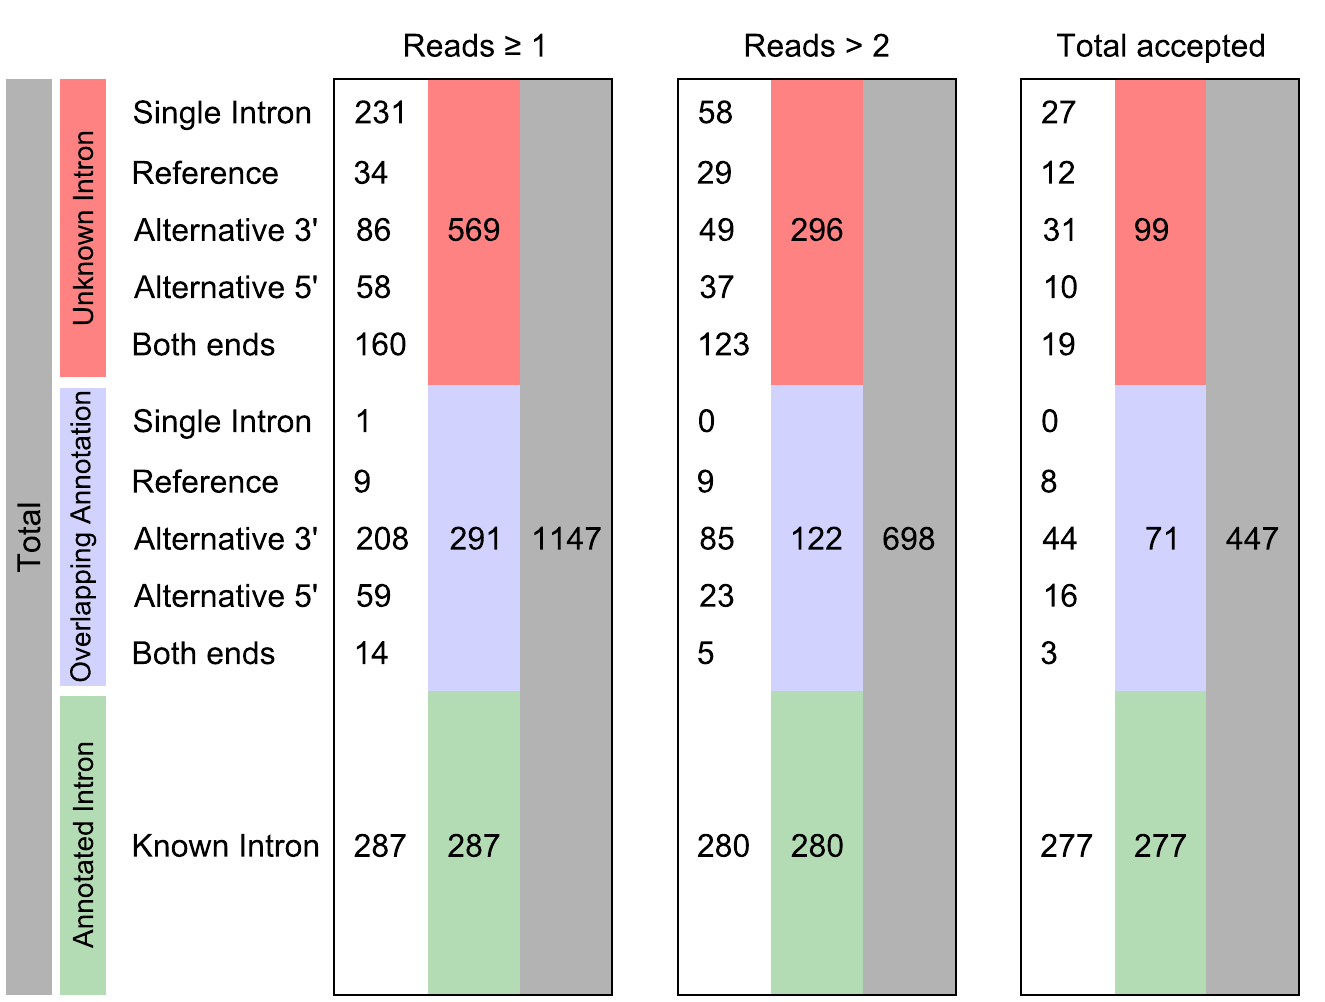
Fig 3. Predicted introns are assigned to different classes. “ Single Introns ” do not constitute evidence of AS events. “ Reference ” are predicted introns with further overlapping introns, i.e. AS events; the predicted intron with highest read support is selected as reference in a group of overlapping introns. The classes “ alternative 3 ’” , “ alternative 5 ’” and variation on “ both ends ” (3 ’ & 5 ’ ) are evidence of AS. Finally, a predicted intron may exactly overlap an annotated intron. Quantities are given for all predicted introns (reads (cid:1) 1, less conservative), for predicted introns with support of more than two reads, and for introns that meet all our requirements (most conservative). See also Fig